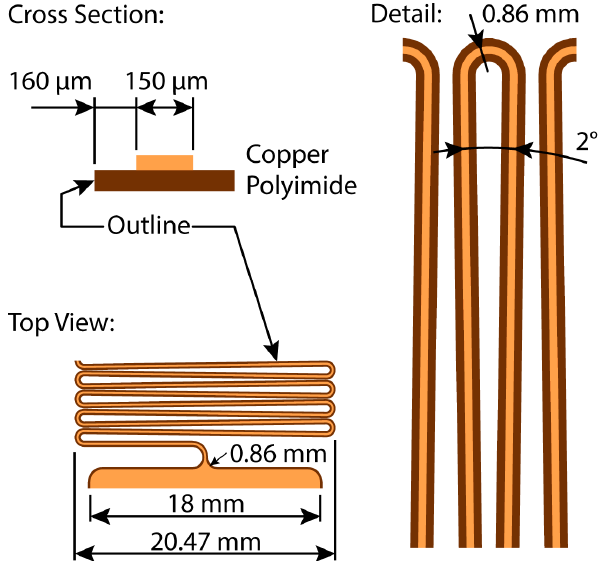
Figure 2. Design details of the stretchable circuit. The side of the polyimide track is the circuit outline. The meanders fold back on themselves at an angle of 2°, optimizing the amount of track in a given surface area without introducing extremely sharp corners.